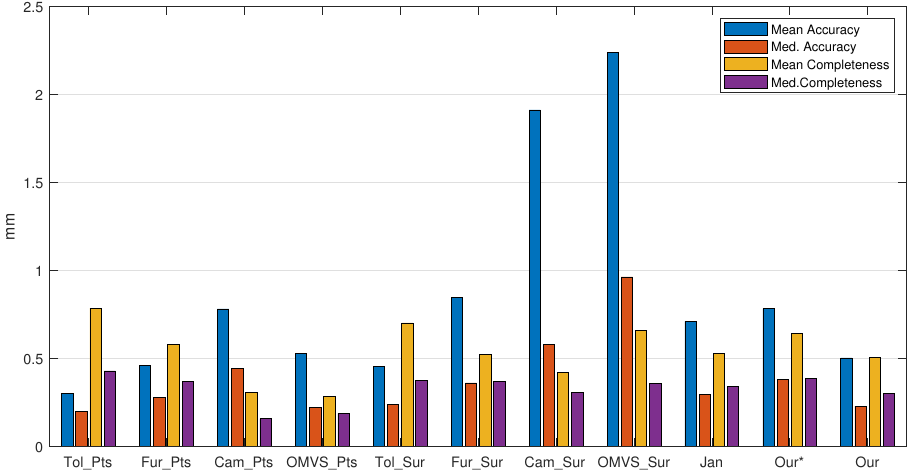
Figure 11. Quantitative evaluation (lower is better) of the methods on MVS dataset [2]. The abbreviations of the methods are given in Figure 10. In addition, OMVS is OpenMVS; Our ∗ is the proposed method without the dense visibility technique; and ∗ _Pts is the point cloud generated by method ∗